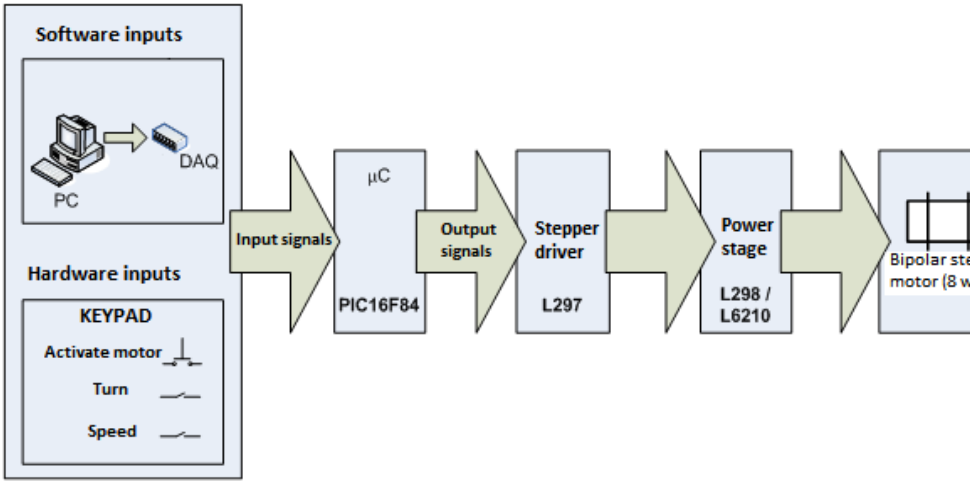
Figure 6. Open loop controller of the stepper